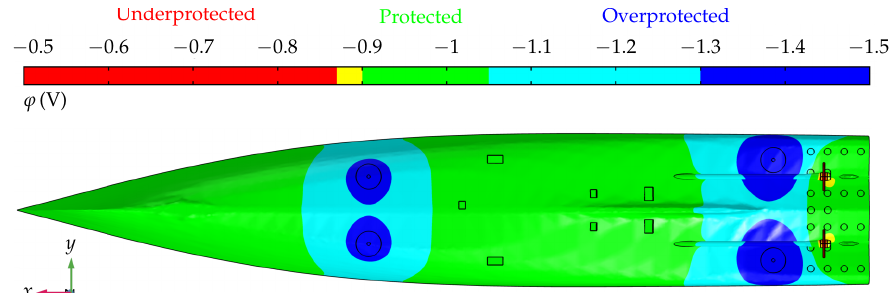
Figure 4. Simulated electric potential distribution as a reference scenario for corrosion protection of the generic ship model. In the shown case, the ICCP currents of the bow electrodes are set to 9A and the ICCP currents of the stern electrodes are set to 15A to match the desired corrosion protection condition for bare steel. Note that the presented example neither includes optimized ICCP electrode positions, nor an optimized SACP